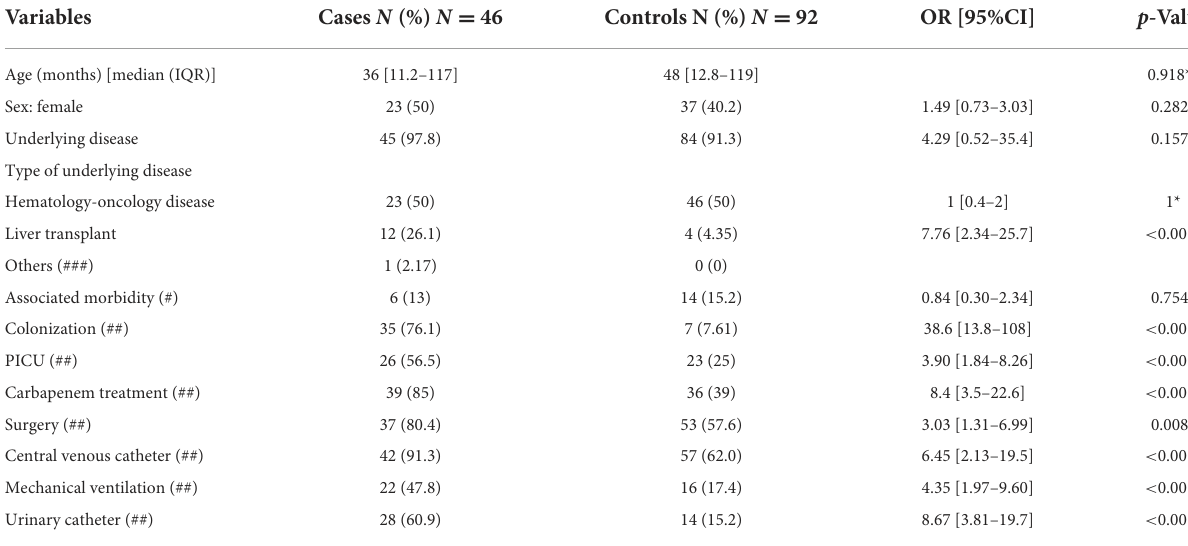
TABLE 1 Demographic and epidemiological data as comparative features between cases and controls.